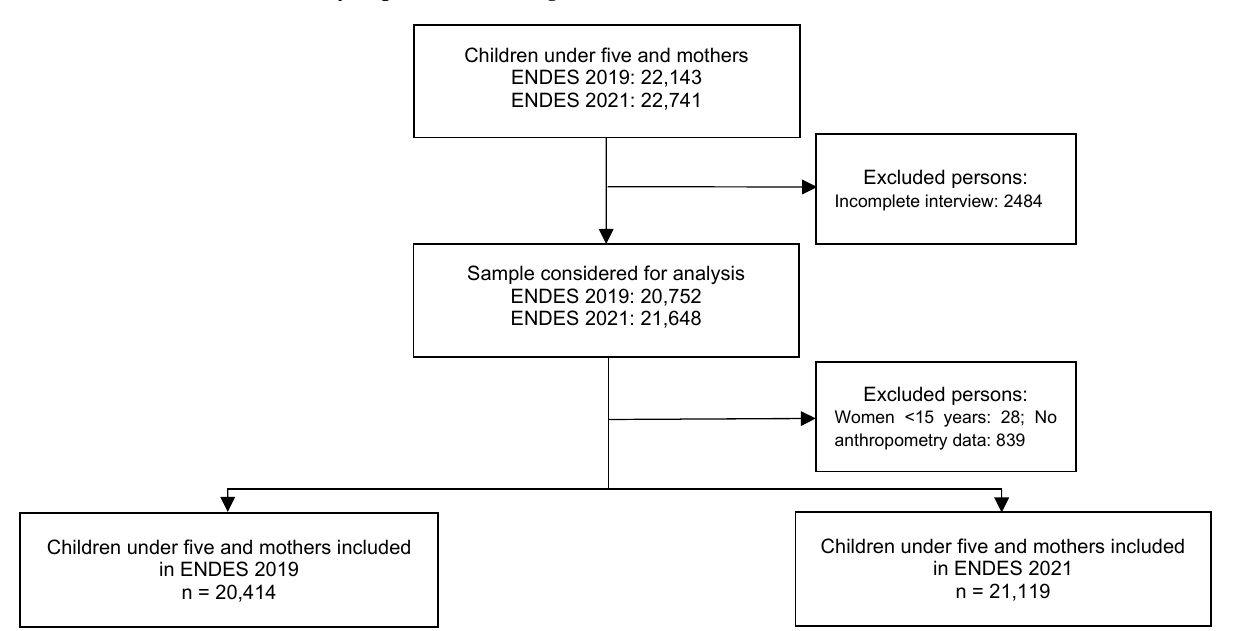
Figure 2. Flowchart of the selection of children under 5 years of age and mothers included in the study.